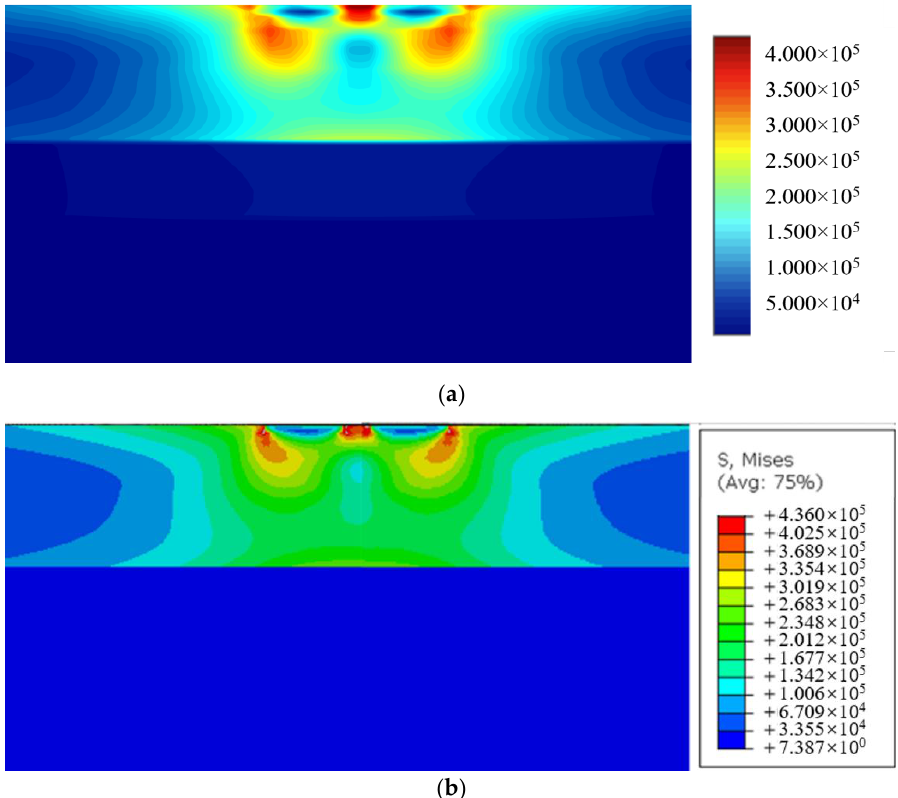
Figure 14. The contours of von Mises stress with bimodular materials for y = 0 by: ( a ) FBM; ( b ) FEM.